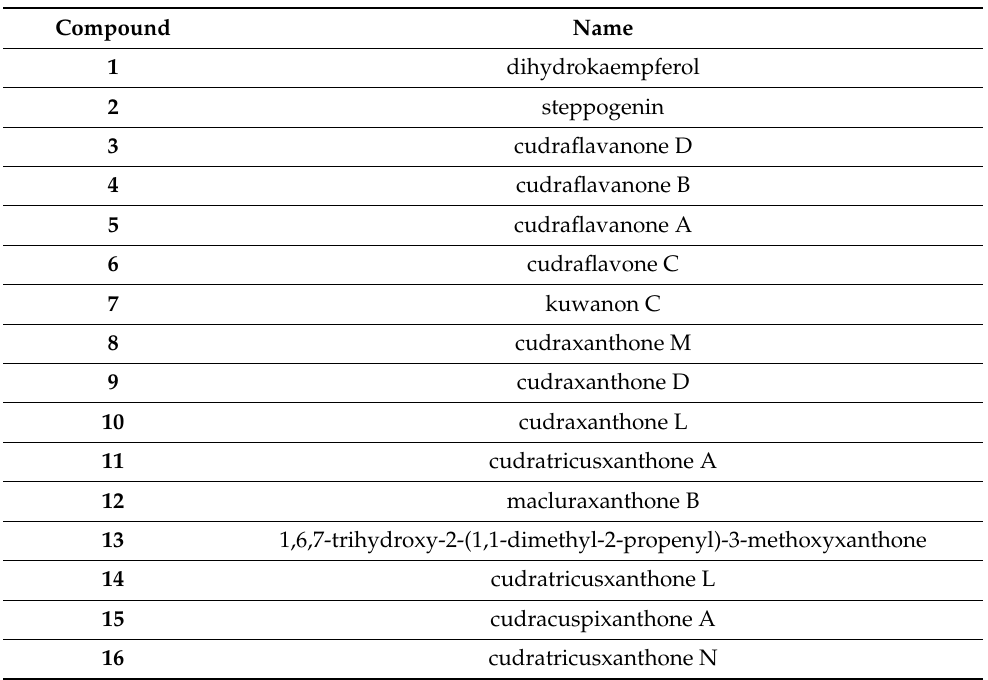
Figure 1. Structure of compounds 1 – 16 . Table 1. List of the 16 compounds evaluated in this